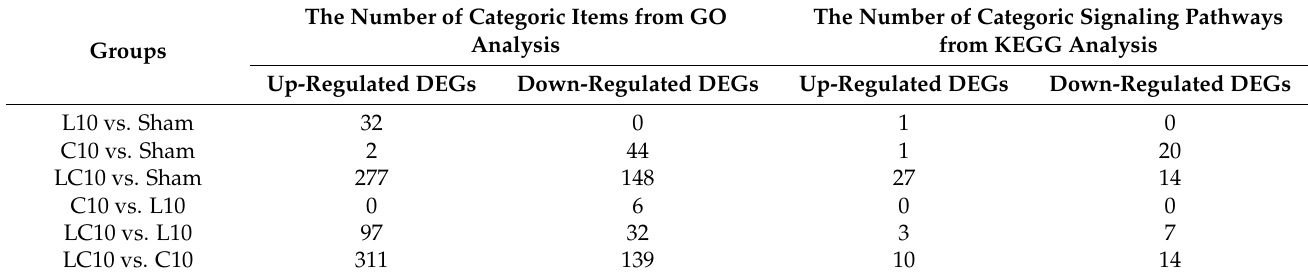
Table 2. The gene set enrichment analysis of DEGs after compound microwave exposure in peripheral